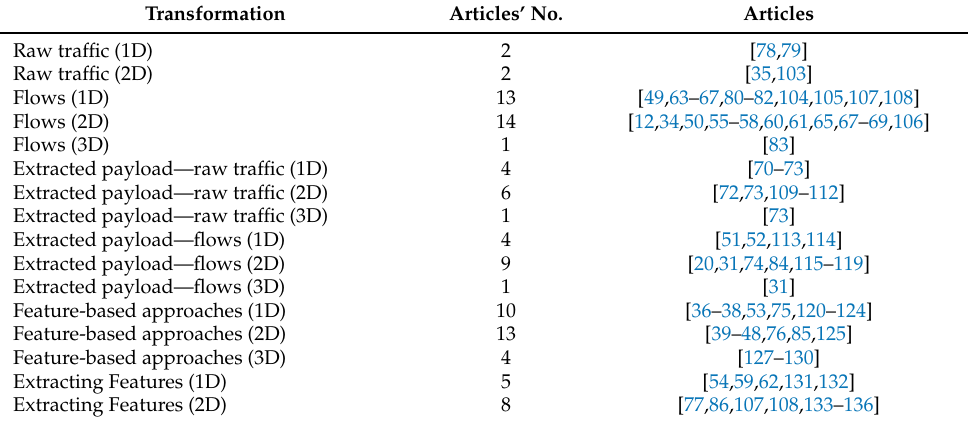
Table 9. The summary of the most common transformation methods of the CNNs’ inputs. Transformation Articles’ No. Articles